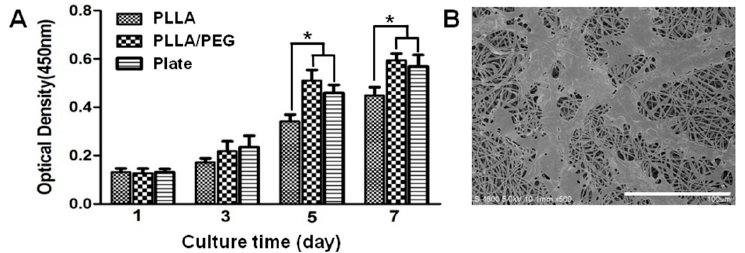
Figure 4. Proliferation ( A ) and SEM images ( B ) of hAMSCs on electrospun PLLA/PEG scaffolds. * p < 0.05. Scale bar, 100 μ m.